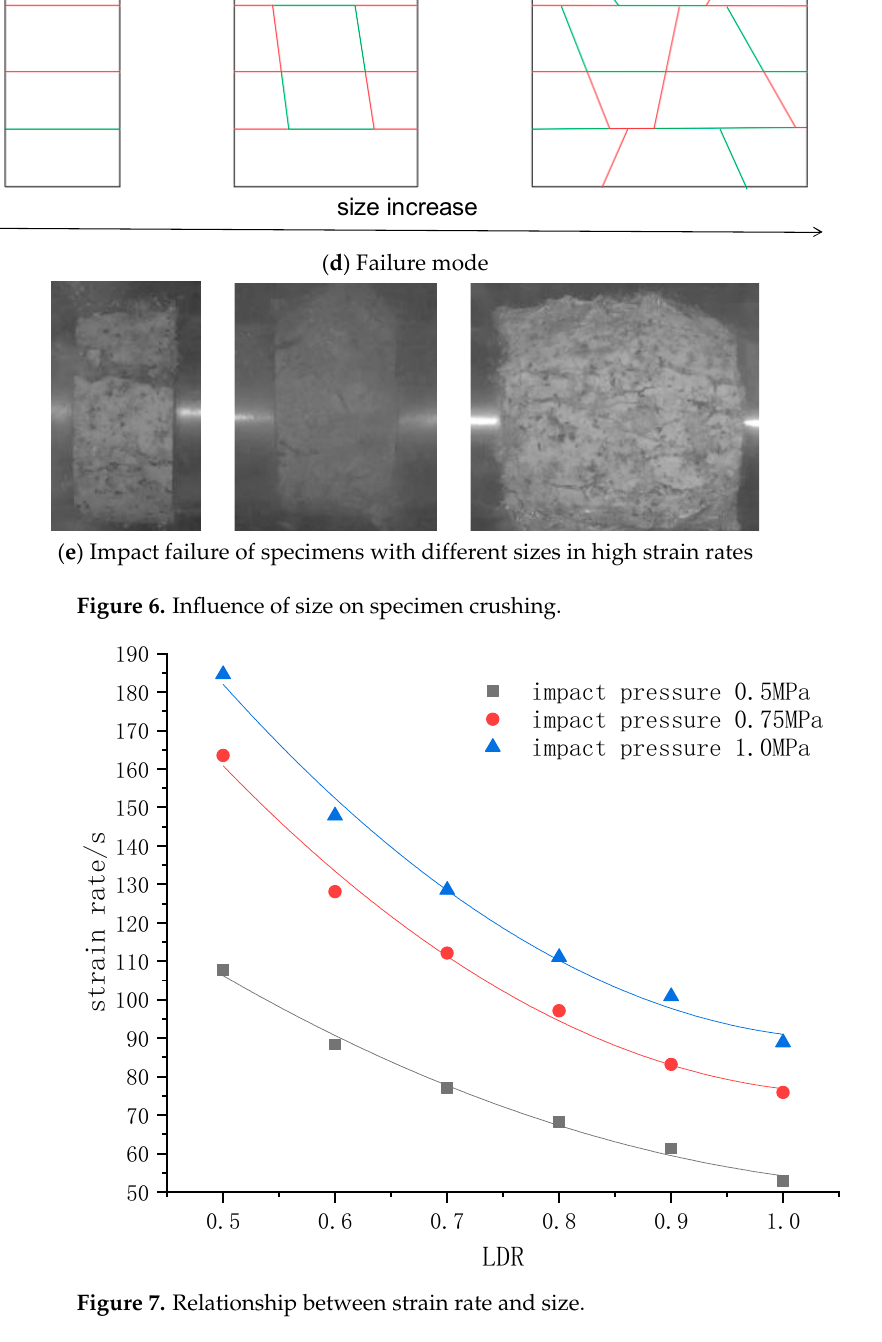
Figure 7. Relationship between strain rate and size.